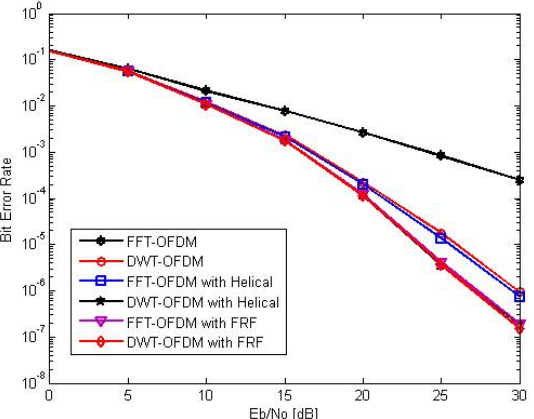
Figure 13. BER performance for FFT − OFDM and DWT − OFDM systems over vehicular A channel.